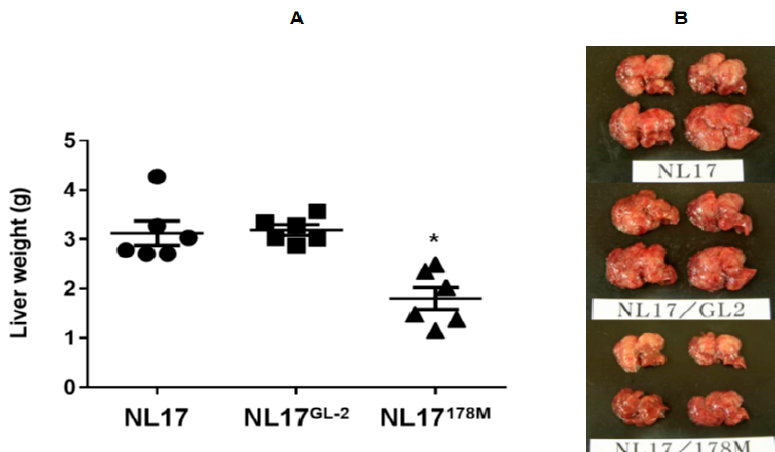
Figure 6. The liver weights 14 days after CLP using NL-17 cells with 178M and control virus in the murine liver metastasis model. A: Liver metastasis of NL17 cells infected with control virus (NL17 GL-2 ) showed similar levels to that of noninfected NL17 cells at 14 day after CLP. In contrast, significant decrease in liver metastasis was observed in NL17 cells infected with 178M virus at moi 100 (NL17 178M ) (n = 6). * p < 0.05 vs. noninfected NL17 cells and NL17 cells infected with control virus (NL17 GL-2 ). B: Representative images of macroscopic liver metastases on day 14 are depicted.